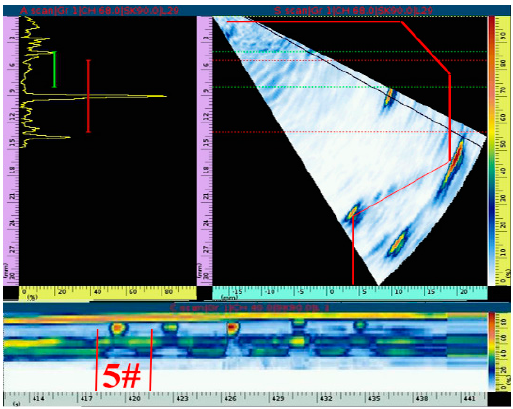
Table 3. Analysis of the test results of different types of defects. Defect Number Defect Size/mm Ampli- tude/dB Reference Amplitude/dB (2 × 40 Transverse Hole)